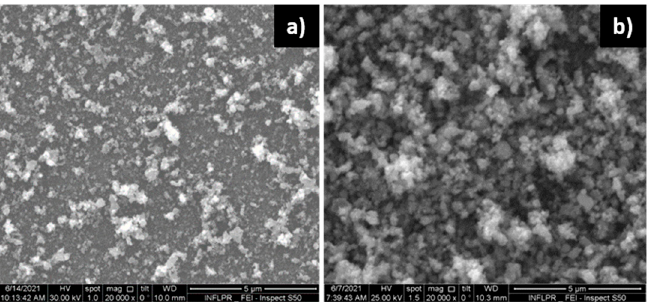
Figure 4. SEM images of ZnO films deposited using a laser wavelength of 1 µm, at a power of 0.2 W and a repetition rate of 10 kHz, in 700 mTorr O 2 , using ( a ) 2h deposition time; ( b ) 3 h deposition